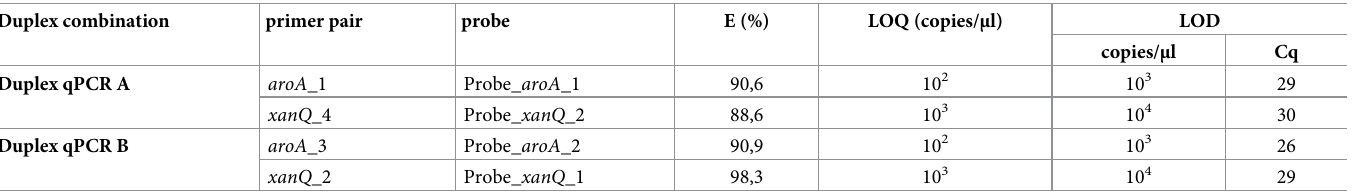
Table 4. Comparison of efficiency, limit of quantification and limit of detection in the two different duplex probe-based qPCR set-ups. For each of the two primer/ probe combinations the efficiency, limit of quantification and limit of detection were assessed using a 10-fold dilution series of a standard fragment (10 8 − 10 0 copies/ μ l). The choice for these specific combinations of primer pairs for both genes was based upon limited primer/probe interactions. Duplex